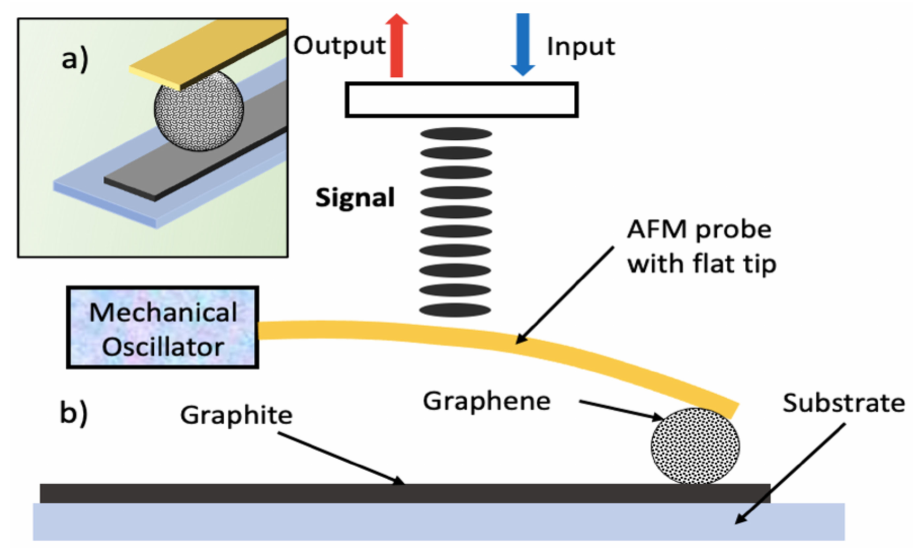
Figure 10. Incommensurate heterostructure interface sliding of multilayer graphene-coated mi- crosphere (GMS) on graphene substrate using tipless mode of atomic force microscope (AFM) ( a ) isometric view and ( b ) schematic of atomic force microscopy of GMS sliding on graphene layers (After